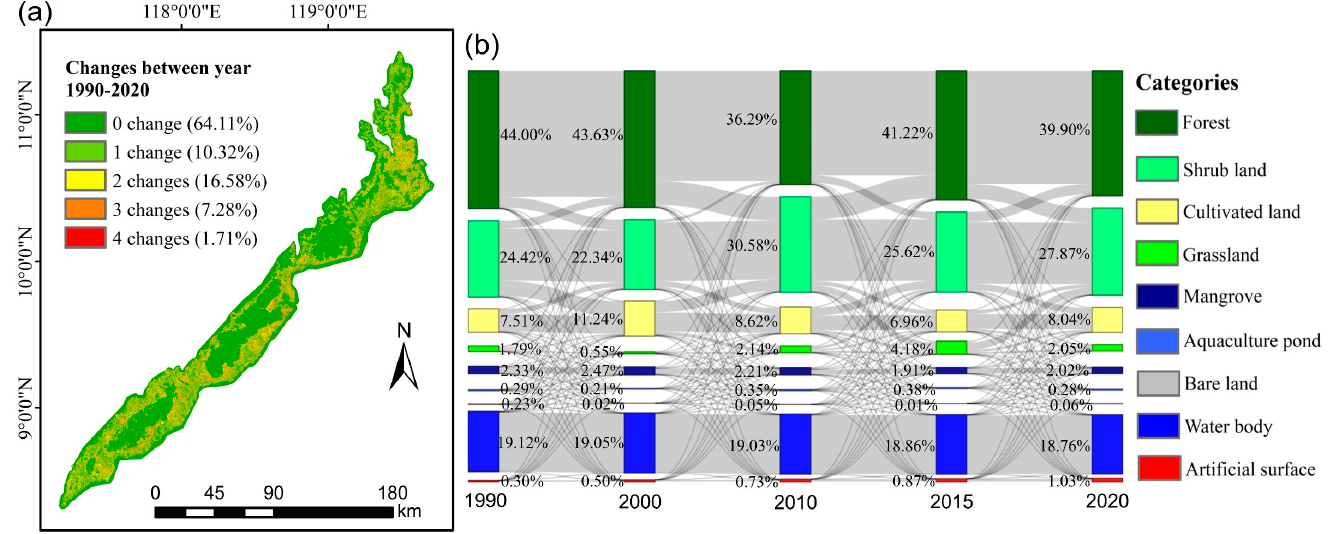
Figure 7. Changes in Palawan from 1990 to 2020. ( a ) Land cover changes and ( b ) change flows between different land cover types.